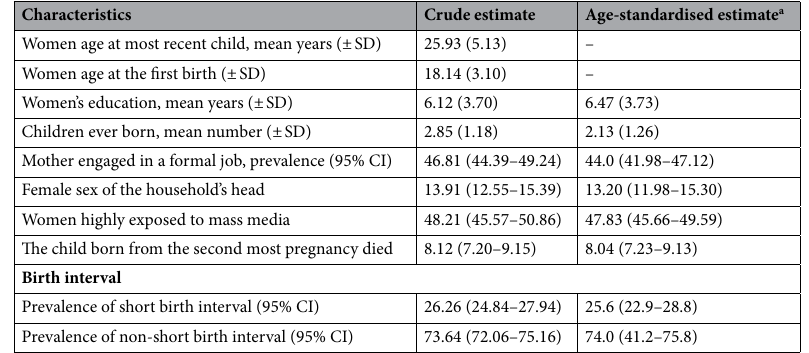
Table 1. Characteristics of the respondents (N = 5941). a Age-standardisation was performed using the age structure of women of 15–49 years included in the 2011 Bangladesh National